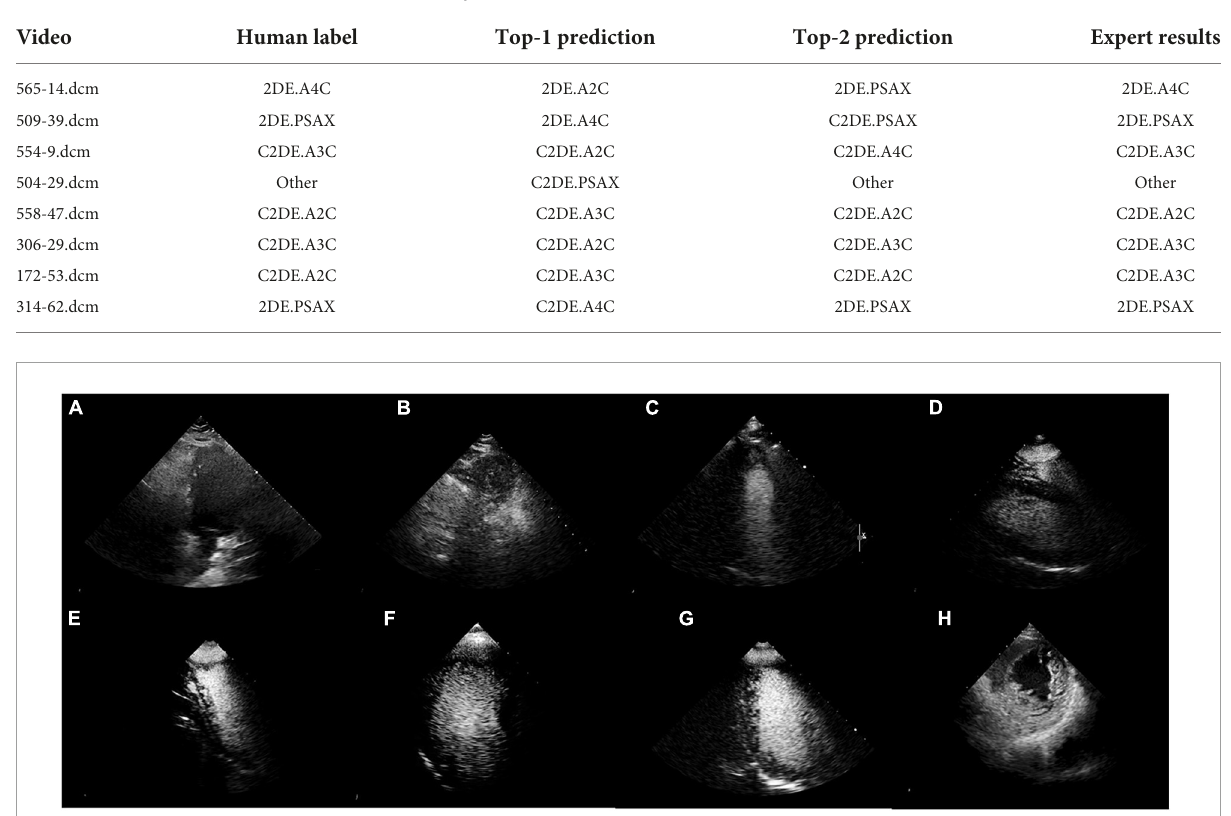
TABLE 5 Videos with the discordance between model prediction and human